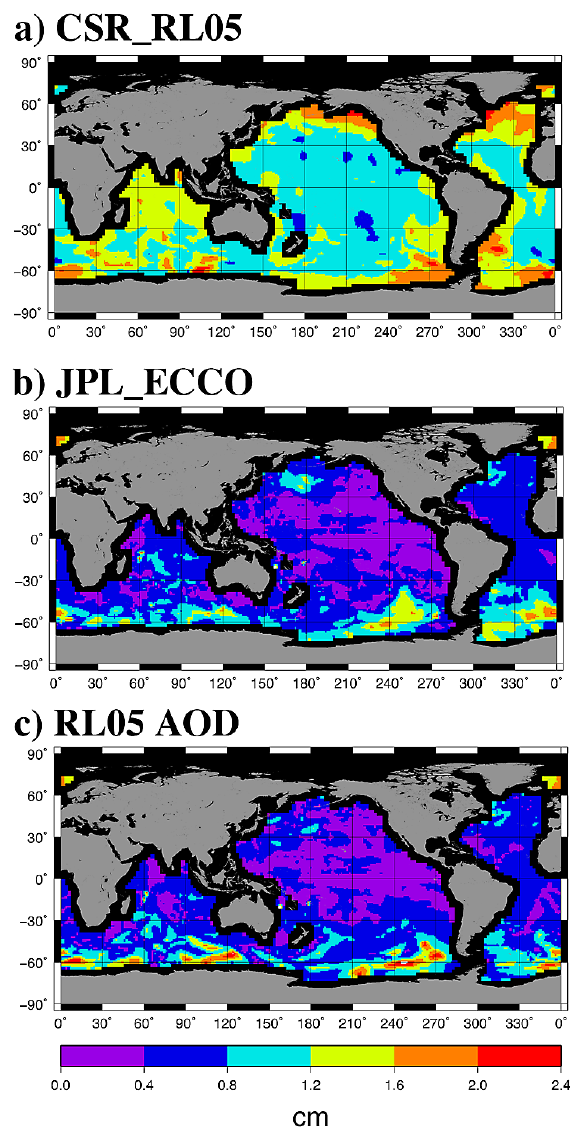
Fig. 9. Estimated standard error in mapped OBP based on Eq. (1) for (a) CSR RL05 (destriped, 500km Gaussian), (b) JPL ECCO (unsmoothed), and (c) RL05 AOD (unsmoothed).